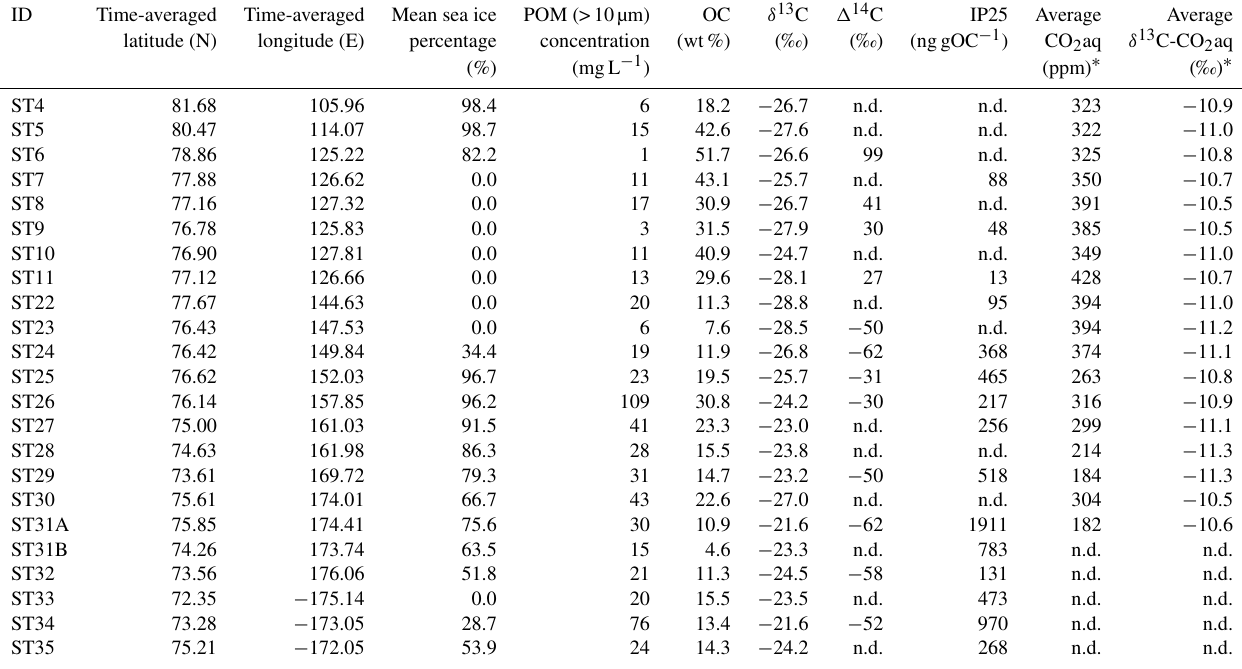
Table 1. Chemical composition of the POM (>10µm) fraction and continuous CO 2 aq measurements ∗ .